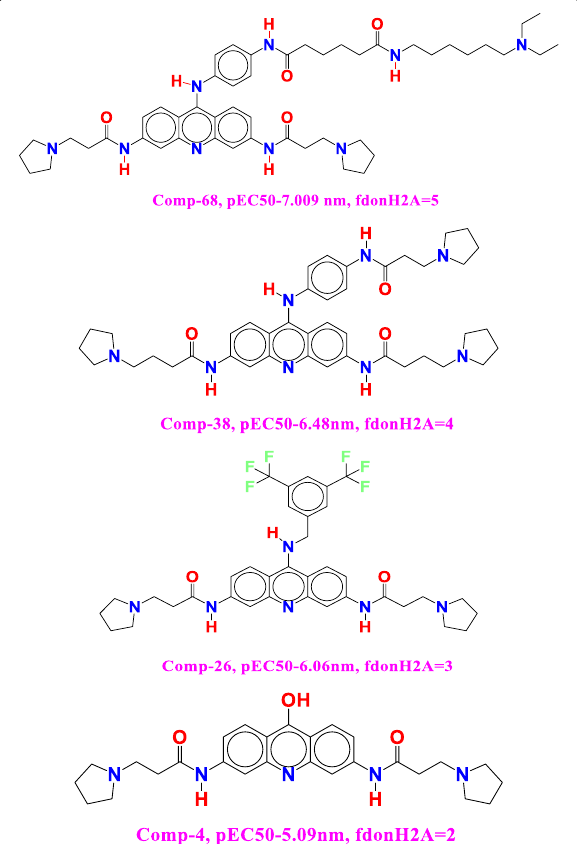
Fig. 11 Depiction of descriptor fdonH2A for compound 68, 38, 26 and 4. (Bold blue colored nitrogen indicates donar while bold red hydrogen atom present within the vicinity of 2 A 0 from